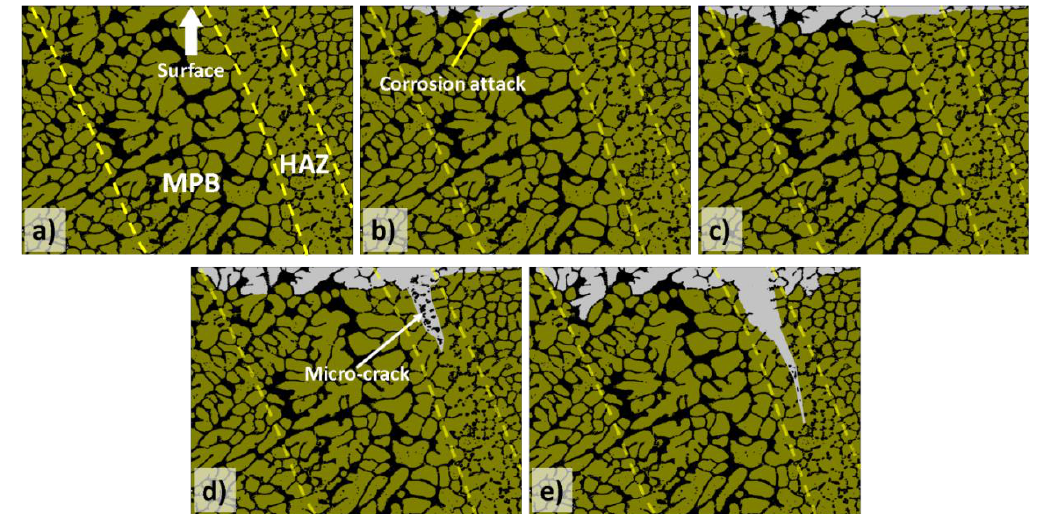
Figure 6. Schematic diagram representing the process of corrosion initiation and corrosion propagation for as-built additively manufactured Al-Si alloys. The illustrations portray the corrosion process seen from a cross-sectional perspective, with the top side of the images representing the surface exposed to the corrosive medium. The Al phase is represented with green, while black portrays the Si phase. A melt pool border (MPB), where a coarser microstructure is seen, and a heat-affected zone (HAZ), characterized by discontinuities in the Si network, can be observed in the images ( a ). The corrosion attack initiates at the MPB, where there is a larger potential difference between the Al and the Si phase, and therefore, a larger driving force for galvanic corrosion ( b ). Because of the partial containment of the corrosion by the Si network, the attack spreads superficially to adjacent zones, reaching the HAZ ( c ). Due to the disruption of the Si network in the HAZ, combined with the existence of internal stresses from the MAM process, micro-cracks are formed along the HAZ ( d ). In a later stage of the corrosion, additional lateral spreading of the attack occurs, accompanied by further propagation of the crack and corrosive medium through the HAZ ( e ) [33].